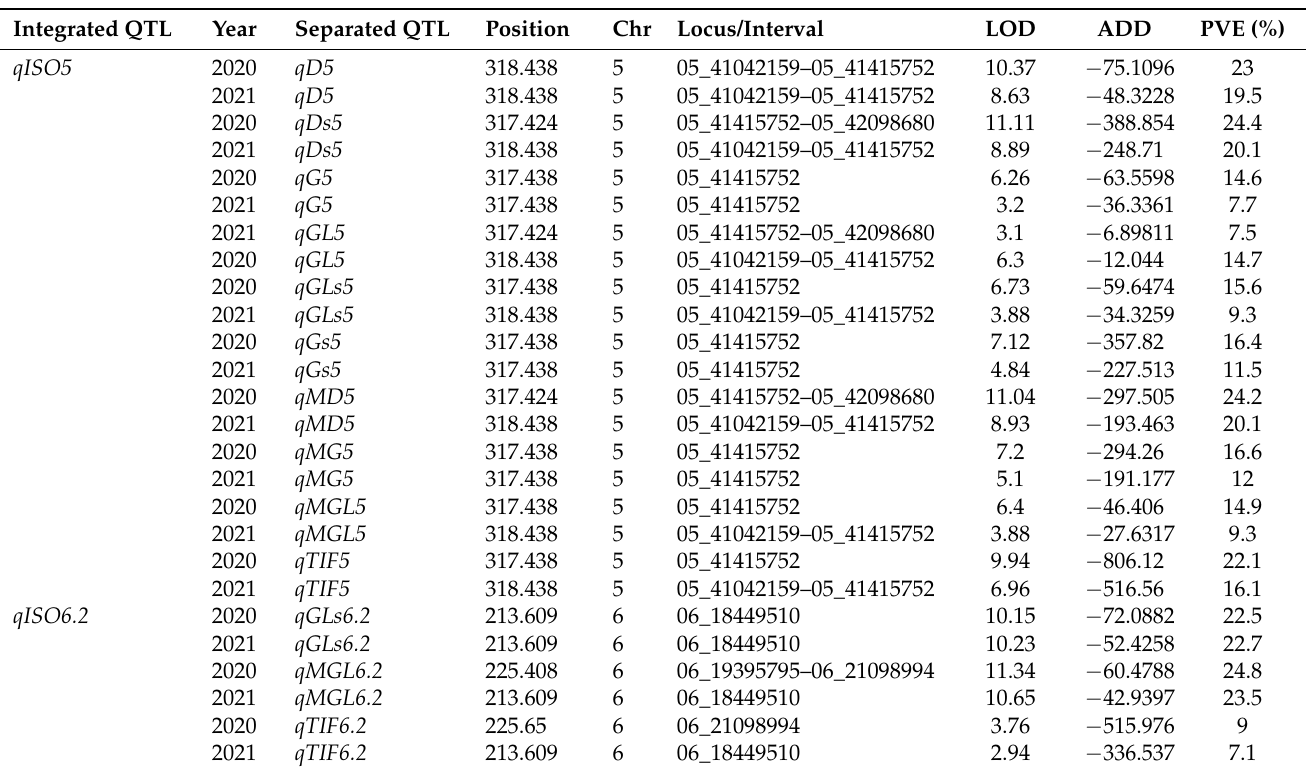
Table 3. Large-effect QTLs for soybean isoflavone traits verified through two years of detection in a population of contrasting soybean parents and 185 RILs of JD12 × Y9.